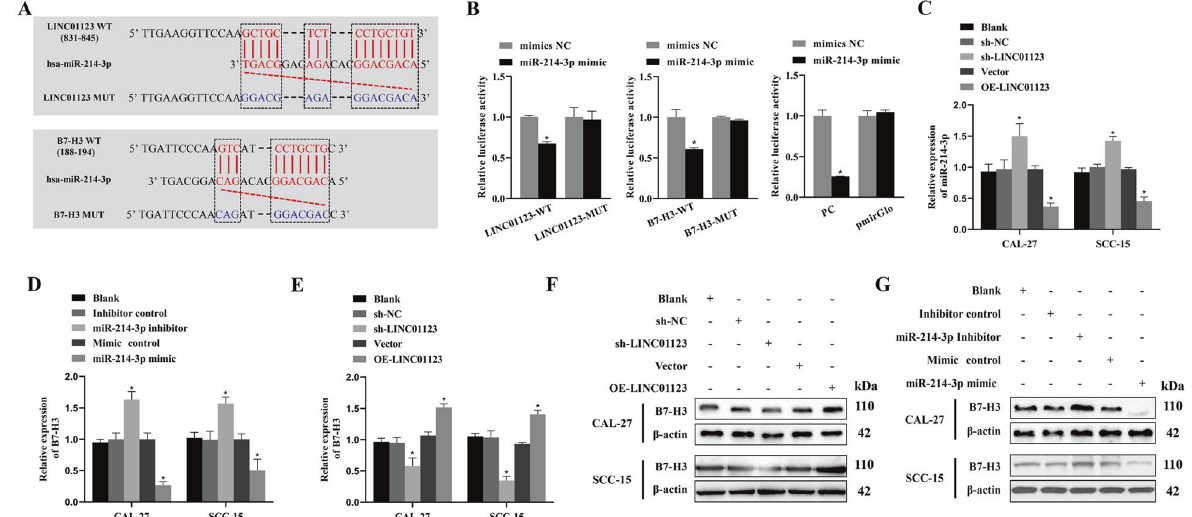
Fig. 2 LINC01123 regulates the expression of B7 – H3 through sponging miR-214-3P. A Plasmids containing wild-type (WT) or mutant (MUT) 3 ′ UTR of LINC01123 and B7 – H3 sequences were constructed. B Dual-luciferase-reporter gene assay was performed to evaluate the direct interactions between LINC01123, B7 – H3 , and miR-214-3P. C Effect of LINC01123 on miR-214-3P expression, as detected by qRT-PCR. D Effect of miR-214-3P on B7 – H3 expression, as detected by qRT-PCR. E Effect of LINC01123 on B7 – H3 expression, as detected by qRT-PCR. F Western blotting was used to detect the impact of LINC01123 on B7 – H3 expression. G Western blotting was used to detect the effects of miR-214-3P on B7 – H3 expression. * P < 0.05 compared with cells without treatment. WT wild-type sequences were constructed into the PmirGlo vector group, MUT mutant sequences were constructed into the PmirGlo vector group, PC positive control group, PmirGlo empty plasmid group, NC normal control, OE over-expression. The experiment was repeated three